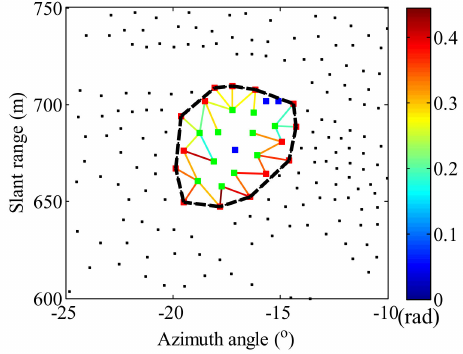
Figure 15. Selection result of the